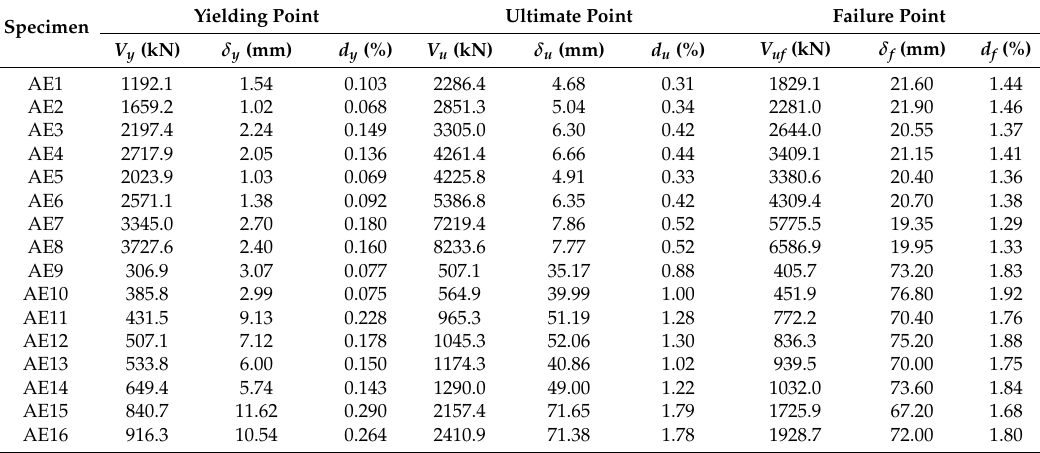
Table 4. Monotonic analysis results of the parametric